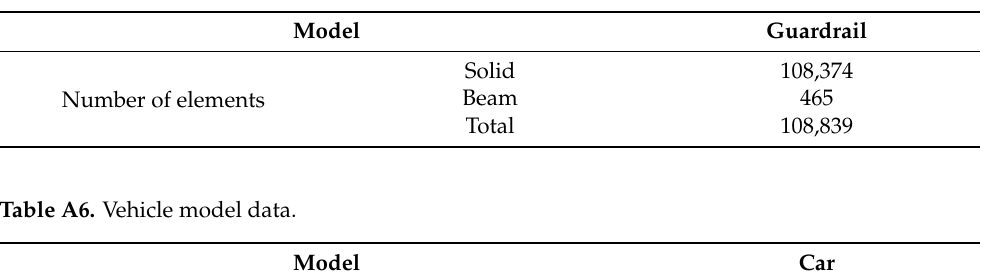
Table A5. Data of the guardrail model.